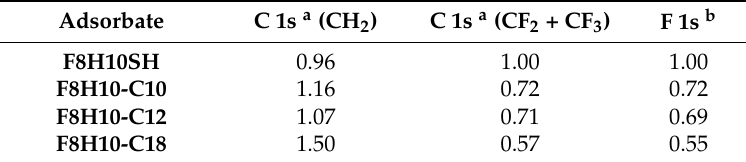
Table 4. XPS Intensities for C 1s and F 1s regions of each fluorinated